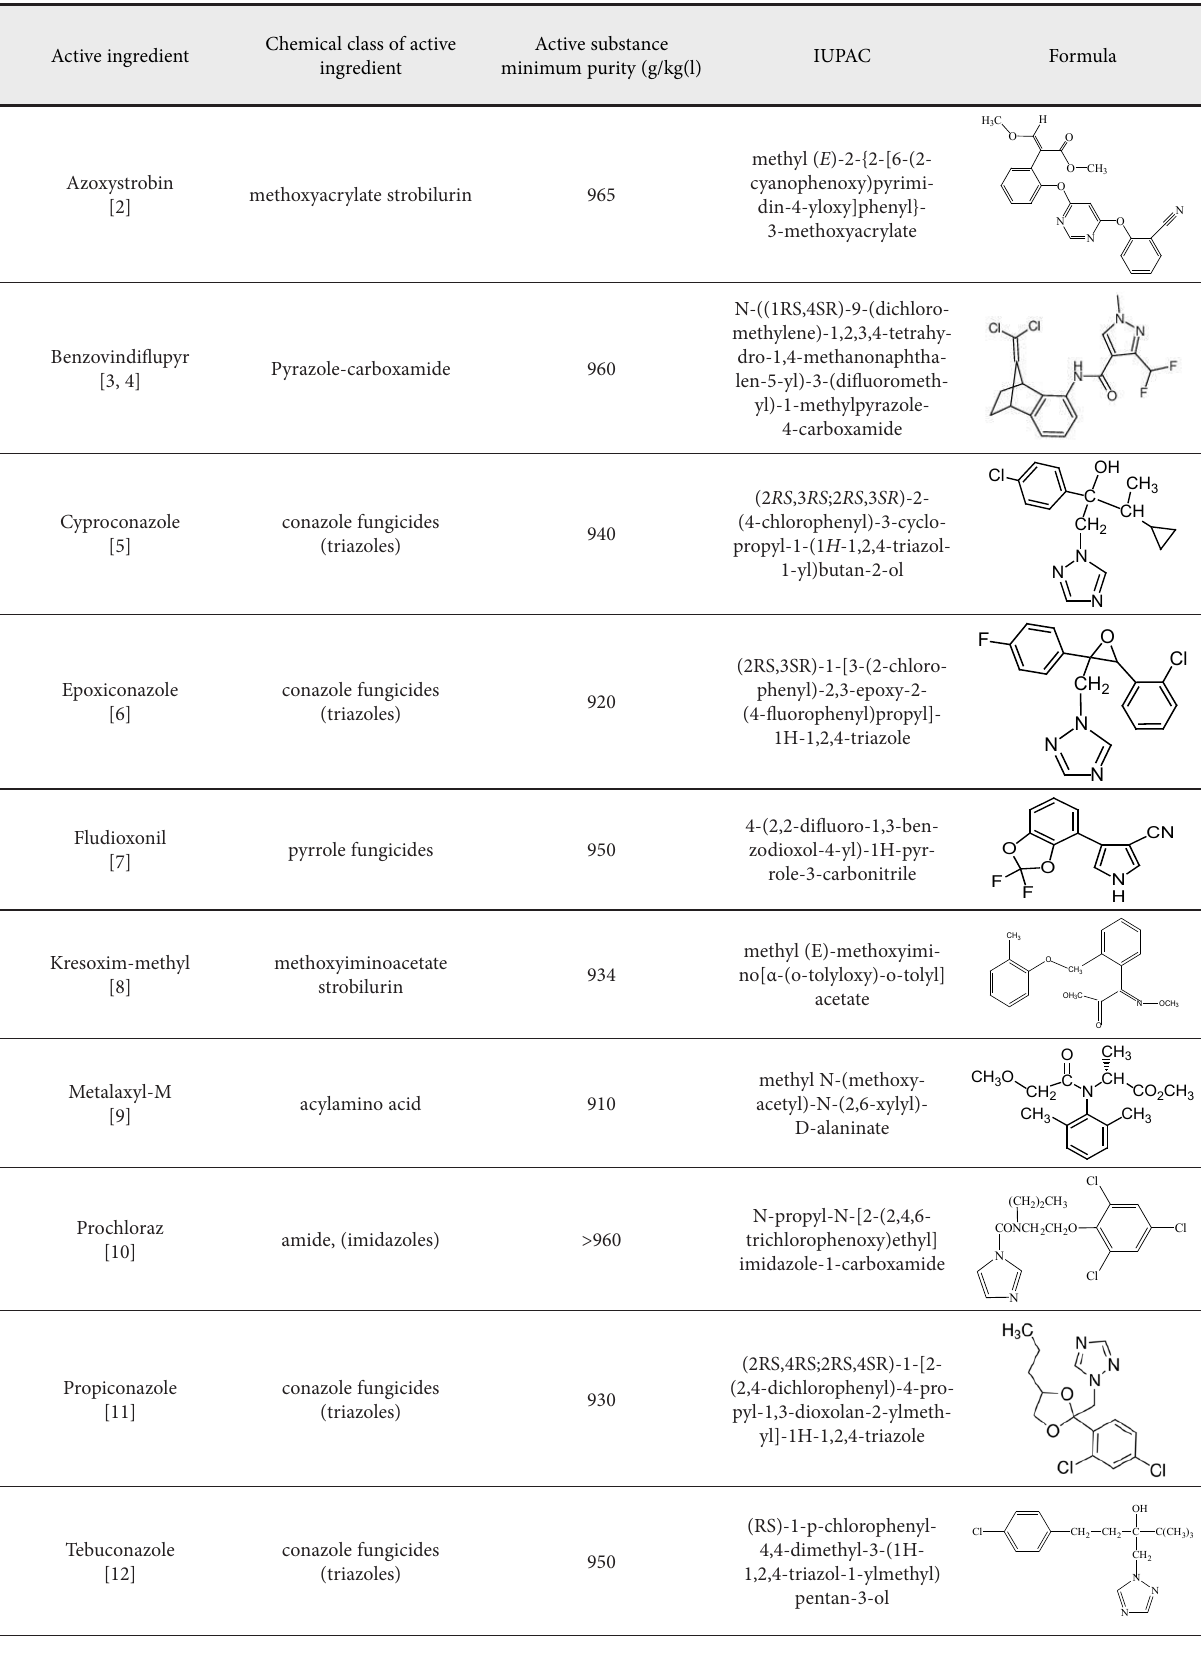
Physico-chemical properties of active substances of combined